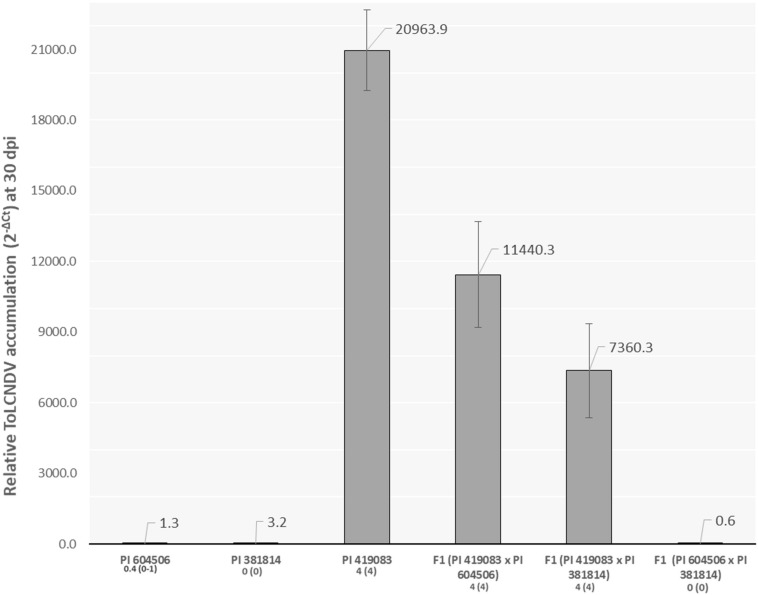
Relative tomato leaf curl New Delhi virus (ToLCNDV) accumulation (calculated as 2– ΔCt) at 30 days after mechanical inoculation (dpi) with ToLCNDV in the resistant Cucurbita moschata accessions PI 604506 and PI 381814, the susceptible control PI 419083, and their respective hybrids. Mean and range of symptoms scores at 30 dpi are indicated in the x-axis legend.